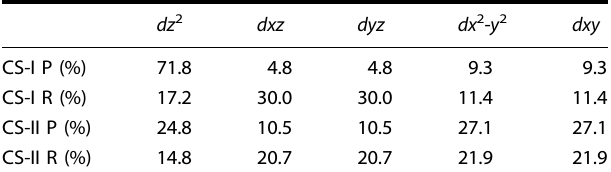
Table 1. The previous (P) and rotated (R) orbital components of CS-I and